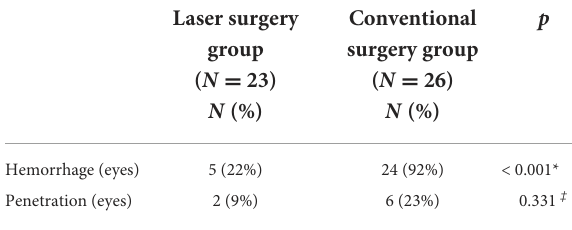
TABLE 2 Complications in identifying and opening SC for both